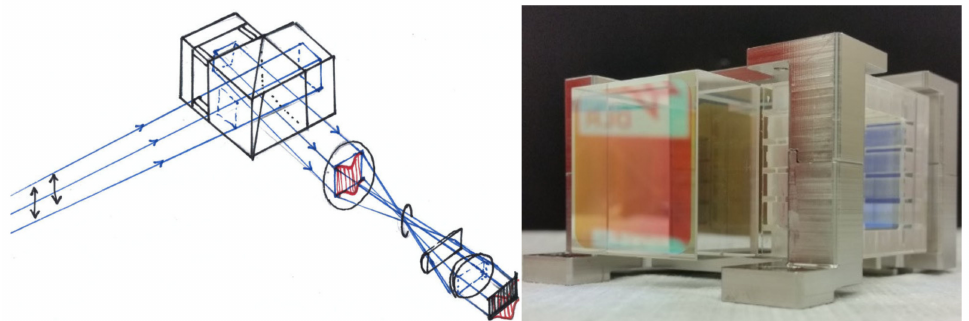
Figure 3. ( Left ): Artist’s impression of the interferometer imaging scheme. Collimated illumination (from left) by a square beam (fiber tip near field), imaging of resulting linear fringe (intensity distribu- tion in red) by cylindrical and conventional lens on one-dimensional detector array. ( Right ): AEROLI demonstrator’s monolithic field-widened Michelson interferometer in its Invar caging, left glass arm, right air arm with